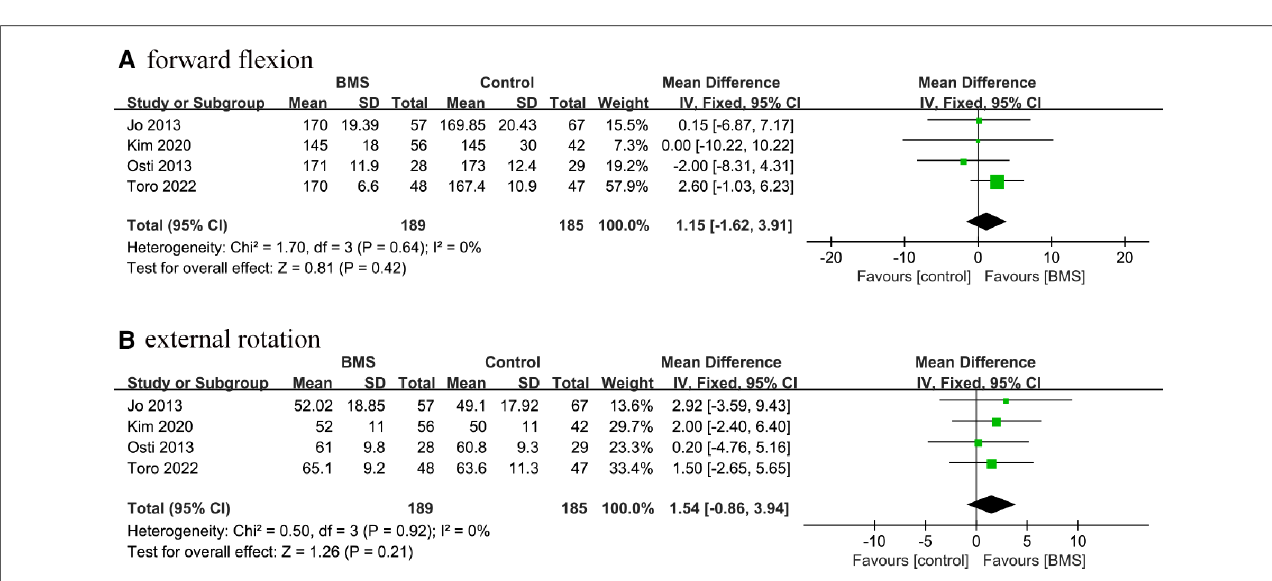
FIGURE 9 Forest plot comparing postoperative ROM between the BMS and control groups. ( A ) forward fl exion; ( B ) external rotation.